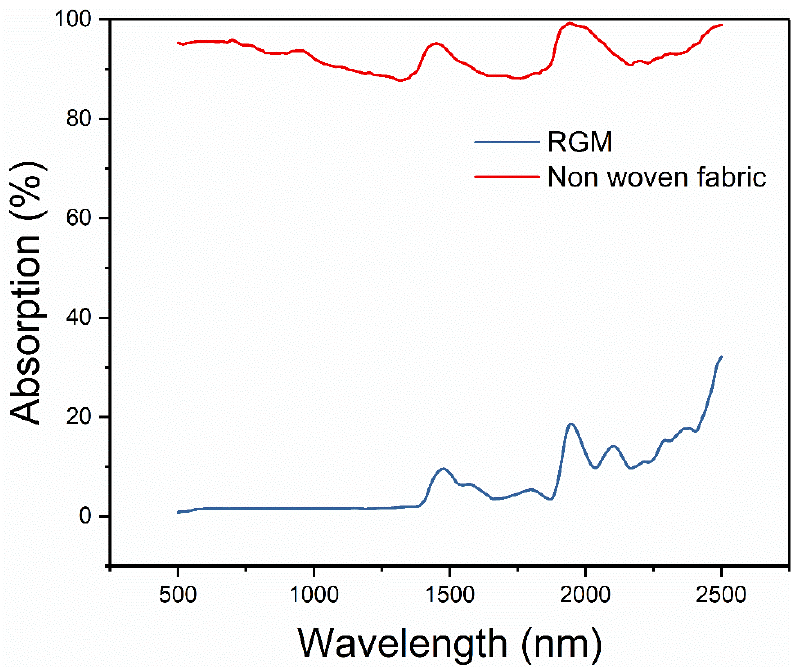
Figure 7. Absorption of RGM and non-woven fabric in the range of 500–2500 nm.